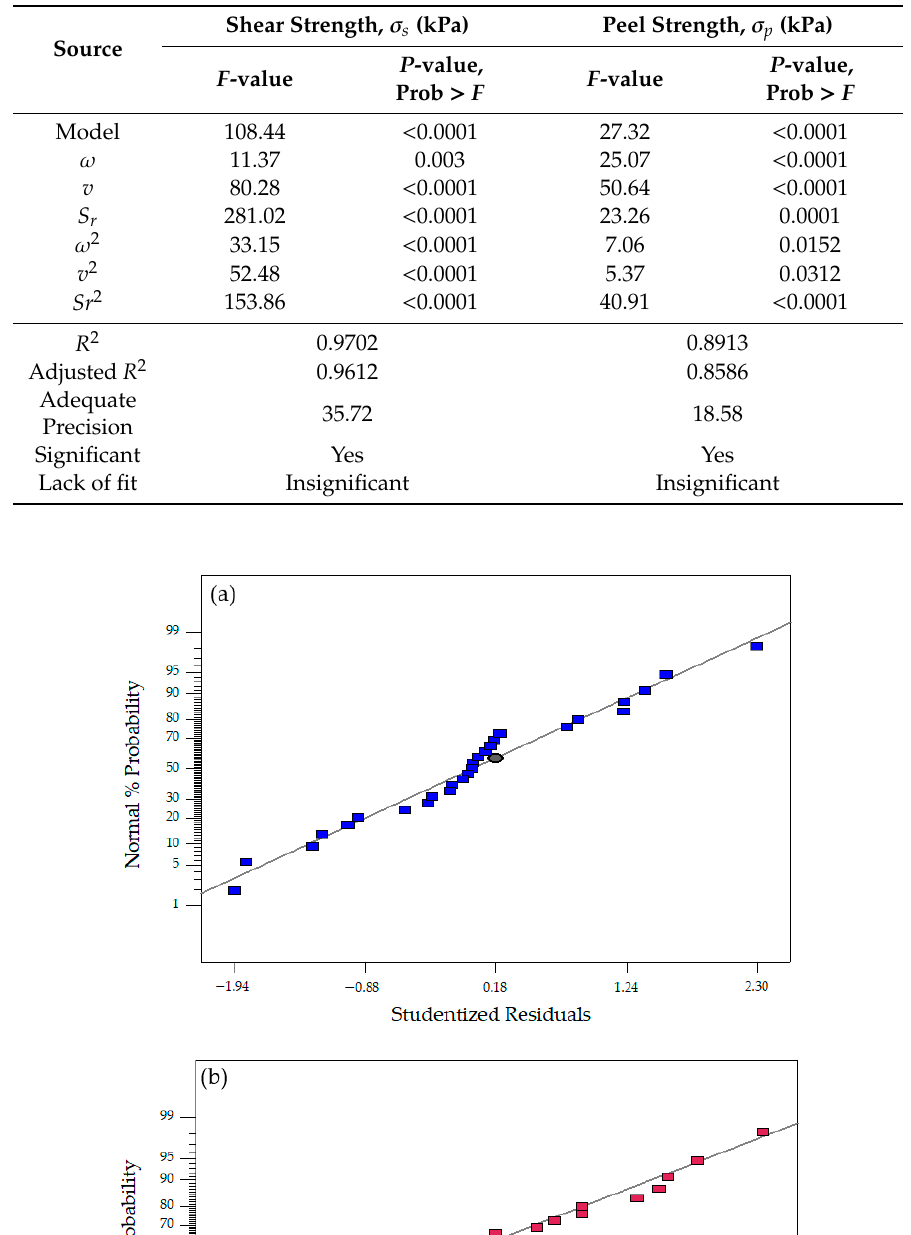
Table 5. Analysis of variance for two responses.